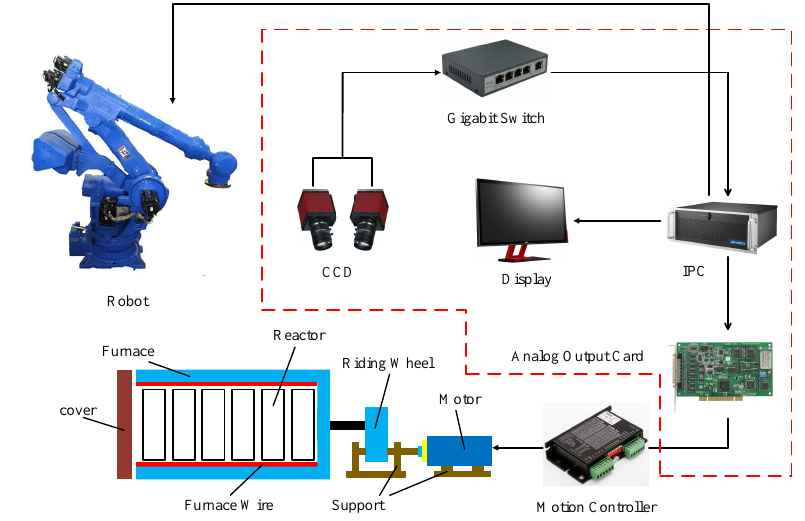
Figure 2. Structure of the automatic unloading system.